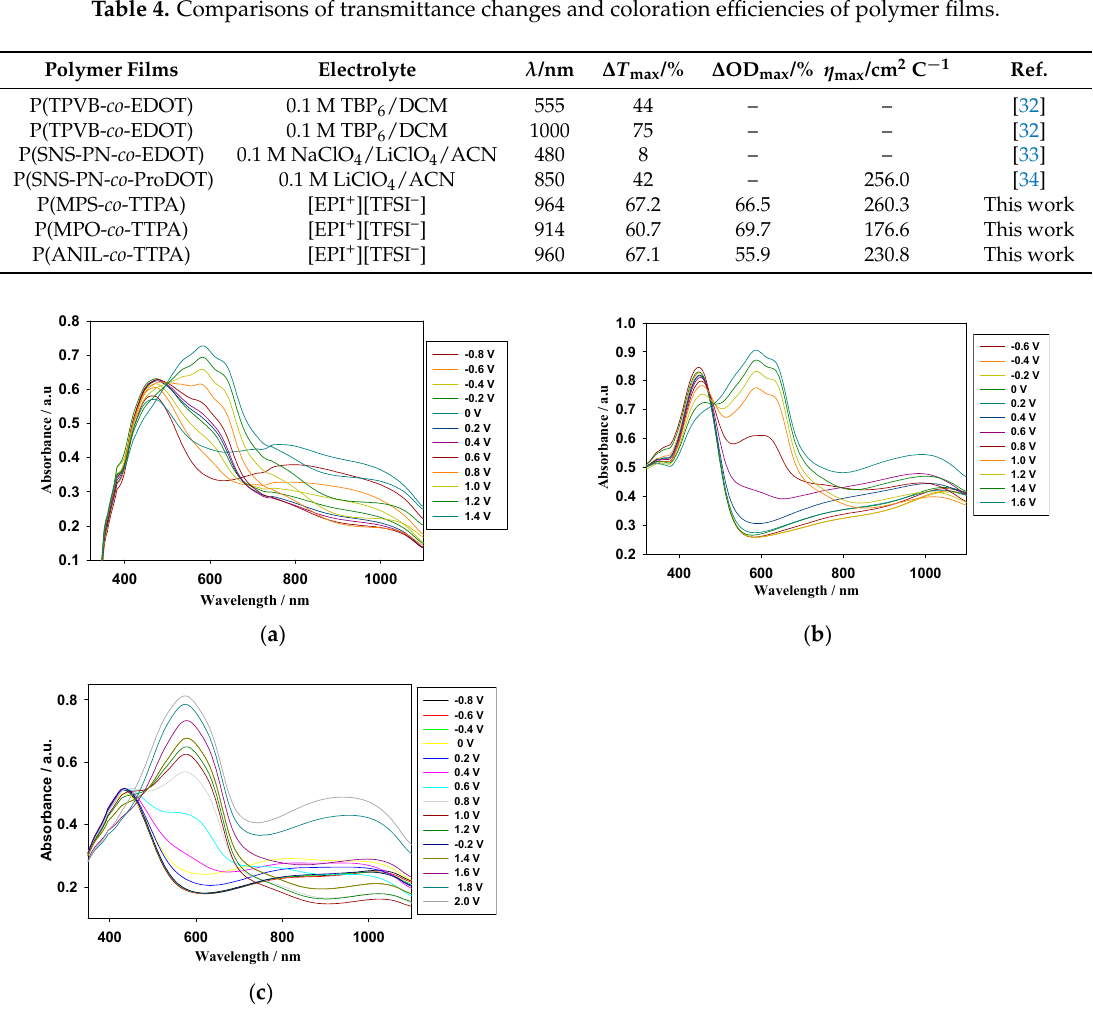
Figure 8. Spectroelectrochemical spectra of ( a ) P(MPS- co -TTPA)/PProDOT-Et 2 ; ( b ) P(MPO- co -TTPA)/ PProDOT-Et 2 ; and ( c ) P(ANIL- co -TTPA)/PProDOT-Et 2 electrochromic devices (ECDs). Table 5. Electrochromic behaviors of ECDs at various voltages.